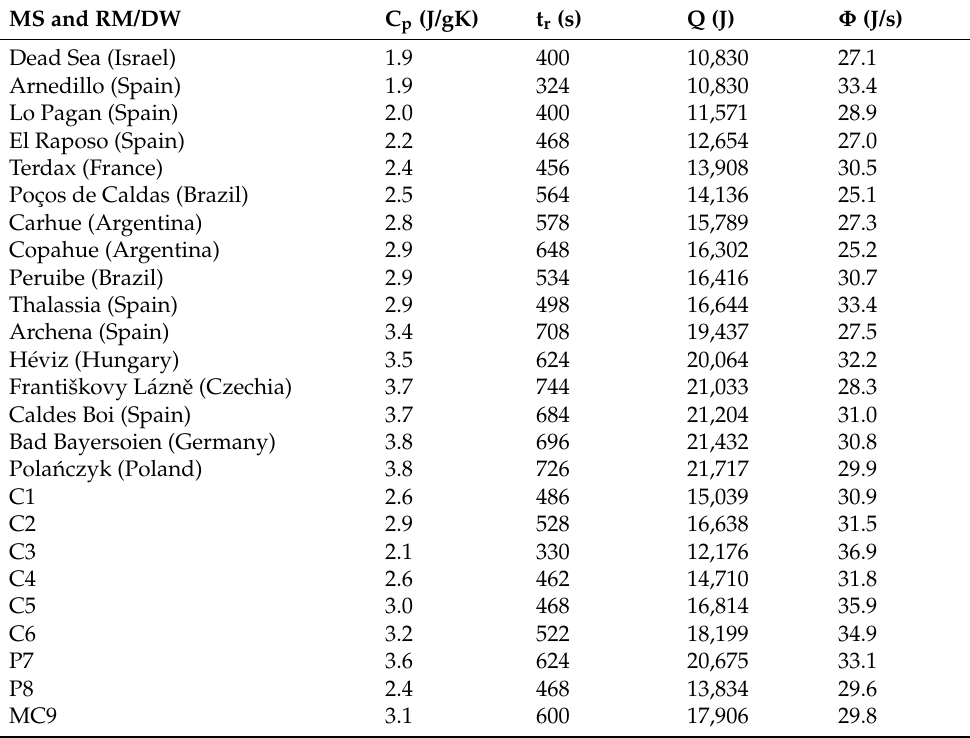
Table 4. Specific heat (C p ), relaxation time, heat amount and heat flow recorded for peloids used in medical spas (MSs) and the pastes (RM/DW) with a hardness of 300 g. MS and RM/DW C p